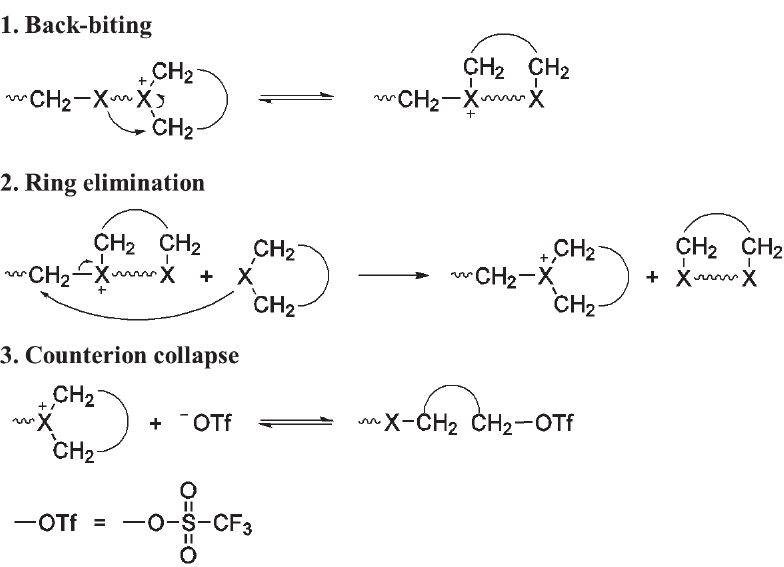
Figure 15. Three principal side reactions during a CROP.